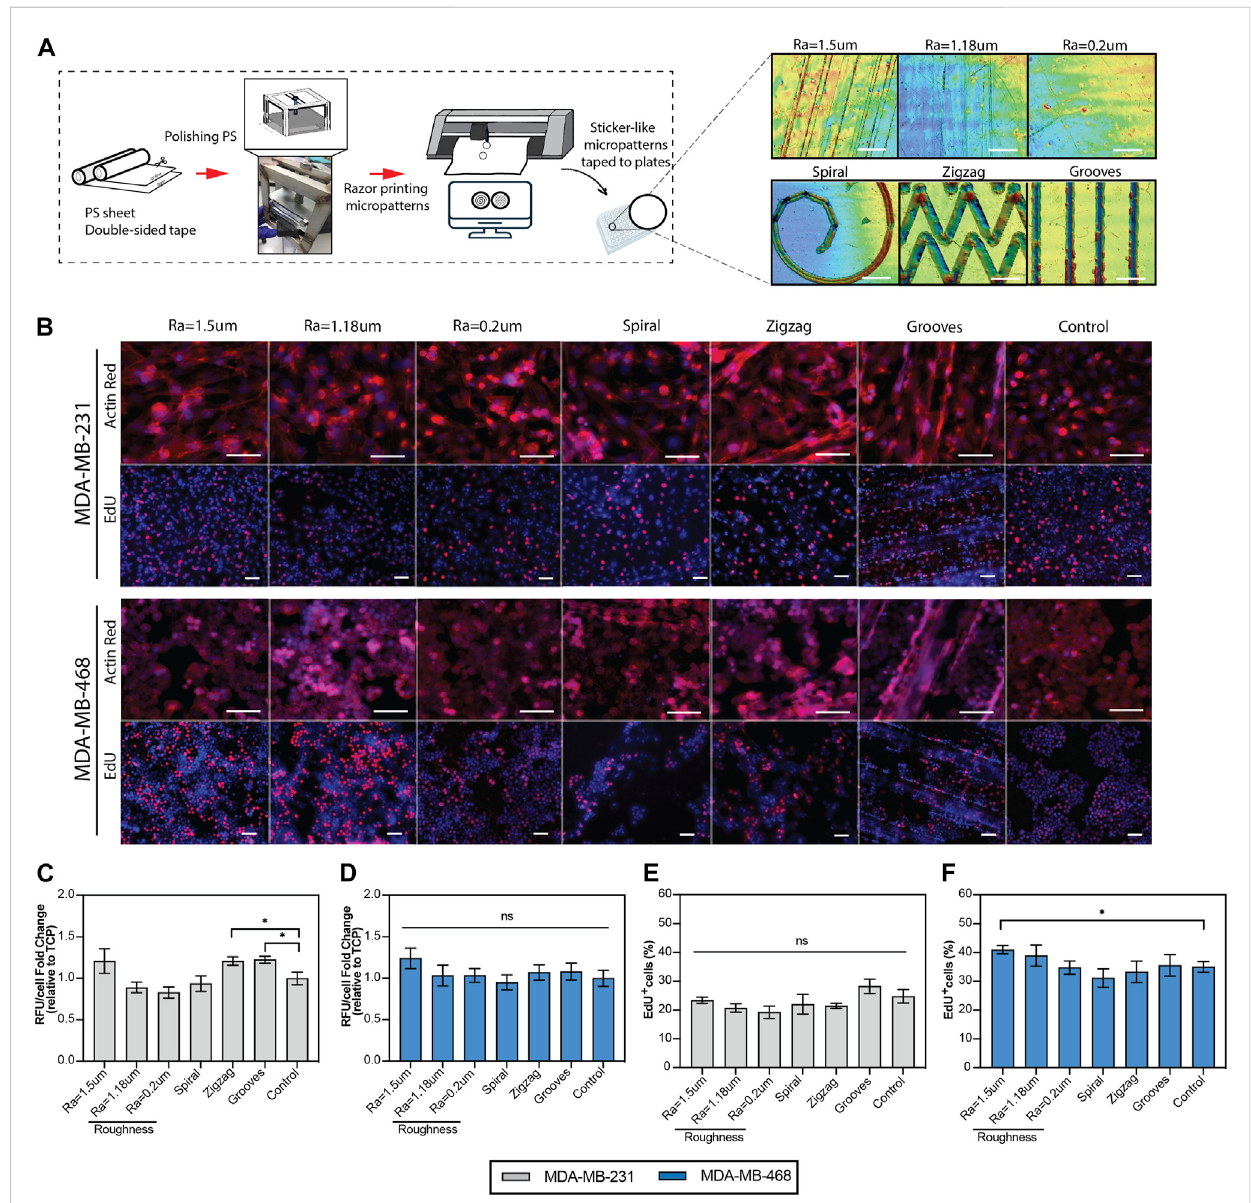
FIGURE 1 ViabilityandproliferationoftheTNBCcellsculturedonthetopographicalsubstrates. (A) Diagramofthegenerationofthepolystyrenetopographical substrates using razor-printing and polishing methods and their characterization by laser confocal scanning 3D microscopy. (B) Top: Representative immuno fl uorescence images of TNBC cells cultured on the topographical substrates and TCP (control). The cytoskeleton of the cells was stained with actin red (red) and the nuclei with hoechst (blue). Scale bar 100 µm. Bottom: Representative immuno fl uorescence images of the proliferation of TNBC cells, where hoechst (blue) represents all the cells and EdU (red) newly synthesized DNA. Scale bar = 50 µm. (C, D) PrestoBlue viability assay of TNBC cell lines, quanti fi ed as relative fl uorescence units per cell, relative to the control (TCP). (E, F) Quanti fi cation of the proliferation of TNBC cells, depictedbythepercentageofEdUpositivecells.TNBCcellswereculturedfor5 daysinreducedserum(2%FBS)onthetopographicalsubstratesandTCP (control). Error bars depict the mean ± SEM of 2-3 independent experiments with n = 3-4 samples. T -test with Mann-Whitney non-parametric test. Asterisk (*) represent p -values < 0.05, (**) p -values < 0.01, (***) p -values < 0.001 and (****) p -values <